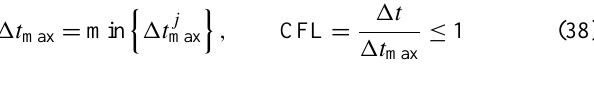
Figure 10. Waterhammer simulation. Pressured head at t = 3 s (red), t = 6 s (green) and t = 9 s (blue).